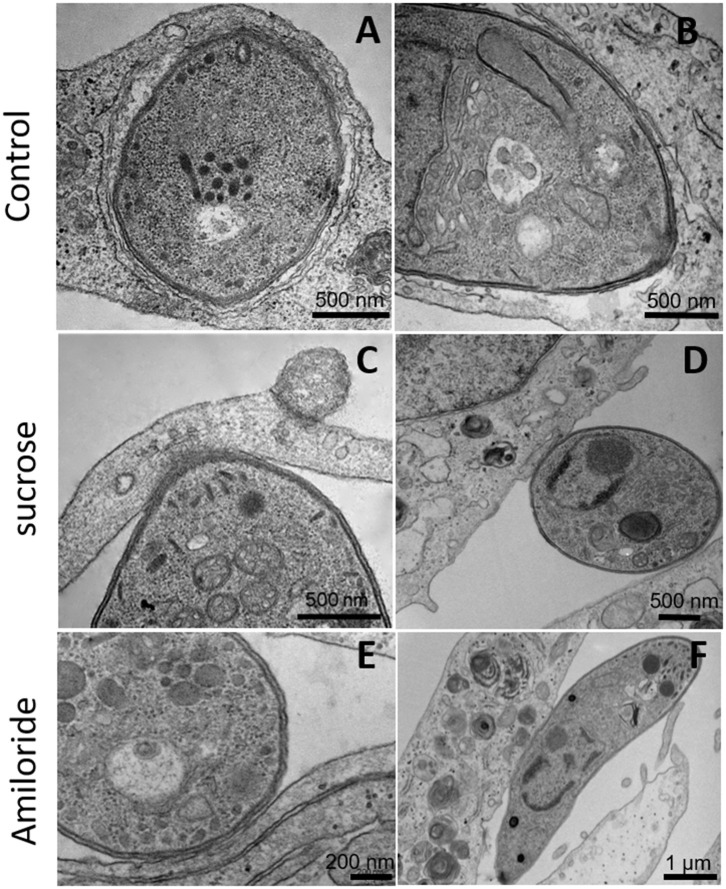
Transmission electron microscopy of HFF1 treated with amiloride or sucrose hypertonic medium, washed with PBS (three times) and allowed to interact with tachyzoites for 1 h. (A,B) HFF cells that were untreated had T. gondii inside the parasitophorous vacuole. (C–F) HFF cells that were previously treated with sucrose or amiloride were found with most of the parasites attached to their surface.